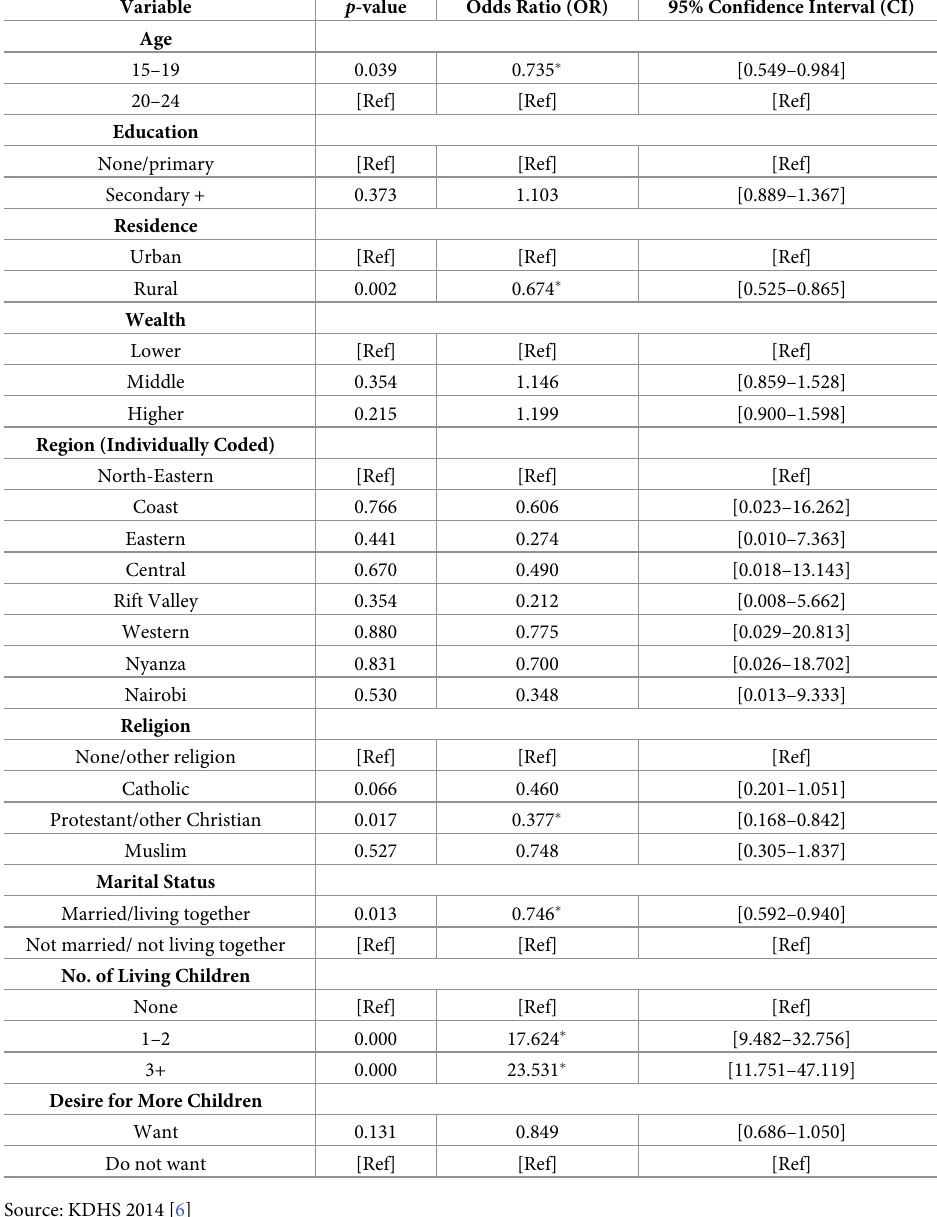
Table 3. Logistic regression estimates for use of LARC among women aged 15–24 in Kenya,